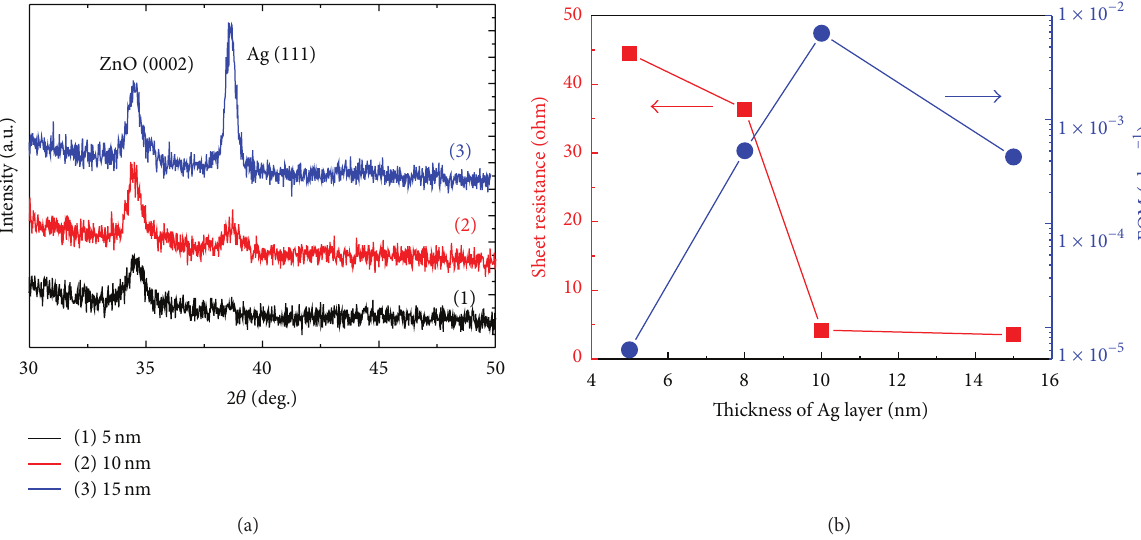
Figure 7: (a) X-ray diffraction spectra of ZAZ films with various Ag thicknesses of 5, 10, and 15nm grown by using RF power of 150 W and (b) the dependence of resistance and FOM of the ZAZ on the inserted Ag